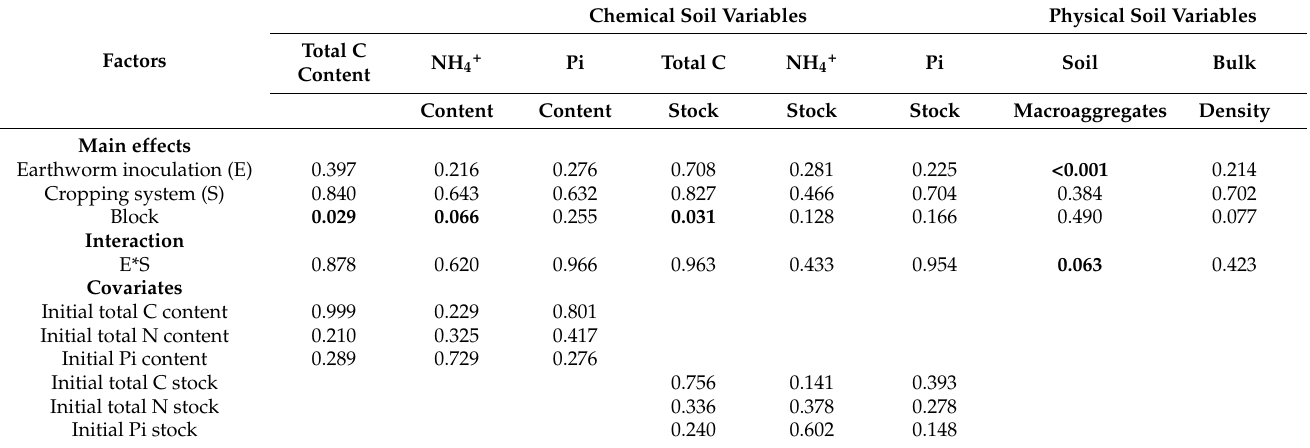
Table 3. p -Values of main effects (earthworm inoculation, cropping system, block) and their interaction and covariates (initial soil properties) on soil physico-chemical variables. ANCOVA and ANOVA were processed respectively for soil chemical and physical variables. Significant p -values are in